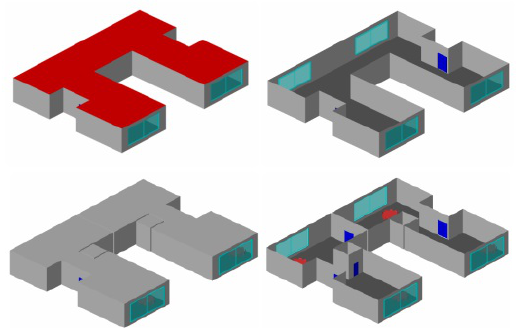
Figure 6: CityGML LoD 3(Top) & CityGML LoD 4 (Bottom) models of Building